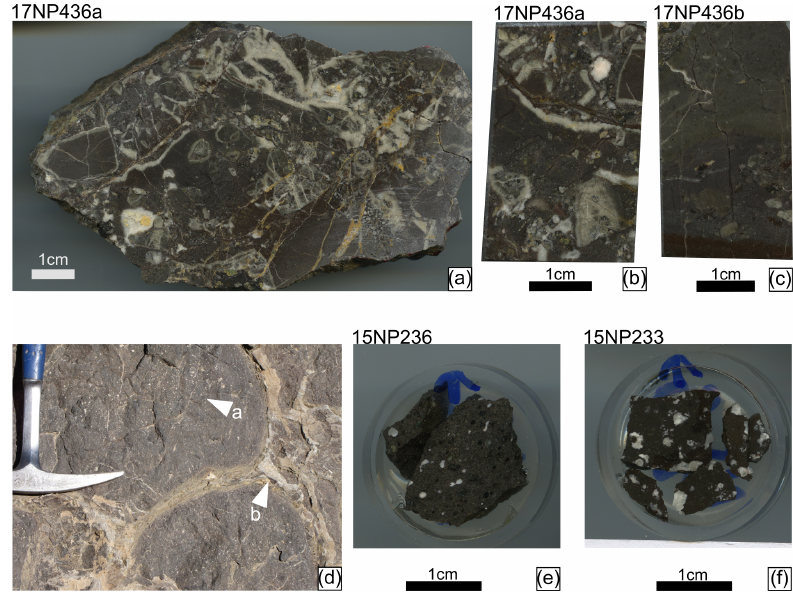
Figure 2. Photographs of hand specimen of sample 17NP436a (a) and polished rock block used for LA-ICP-MS measurements of sample 17NP436a (b) and 17NP436b (c) . Field photograph of well-preserved amygdaloidal pillow basalts in Oytag valley near Qimgan valley (d) , with white arrows pointing at calcite-filled vesicles (arrow a) and massive interstitial calcite (arrow b). Polished rock specimen 15NP236 (e) and 15NP233 (f) of similar rock were used for